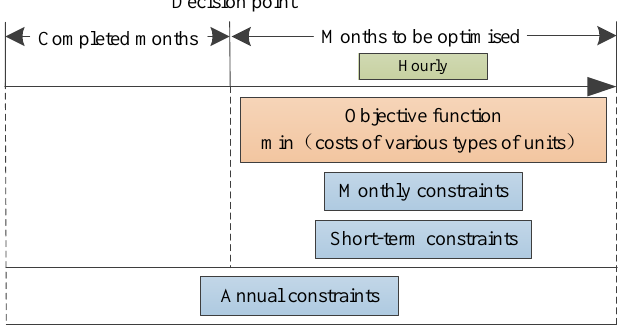
Figure 1. The monthly energy-trade scheduling model according to the typical time-sequence simulation.